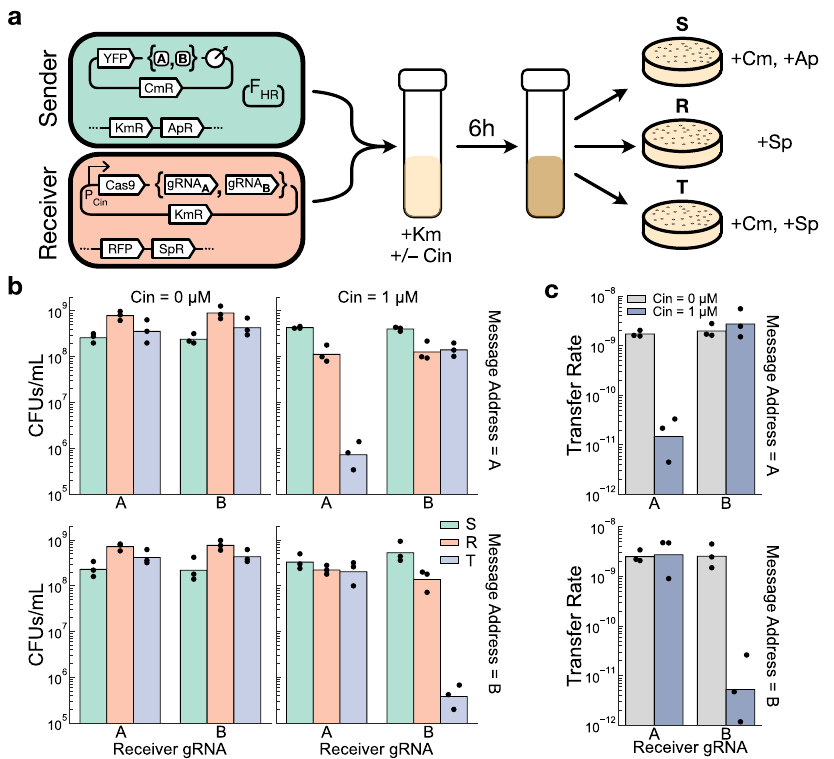
b Endpoint strain densities, measured in colony forming units (CFUs) per mL of culture.( c )Transferrates,calculatedas T /( S ∗ R ),ofthemessageplasmidineachof the conditions in ( b ). Dots show the values from three biological replicates mea- sured on different days, and bars depict the geometric mean of these values. Km